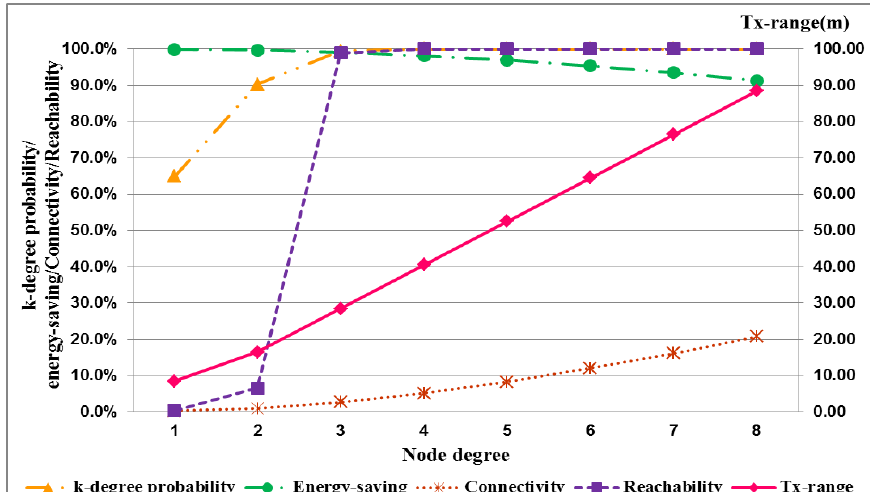
Figure 5. The corresponding relationship of network evaluations with a node density of 0.005 nodes/m 2